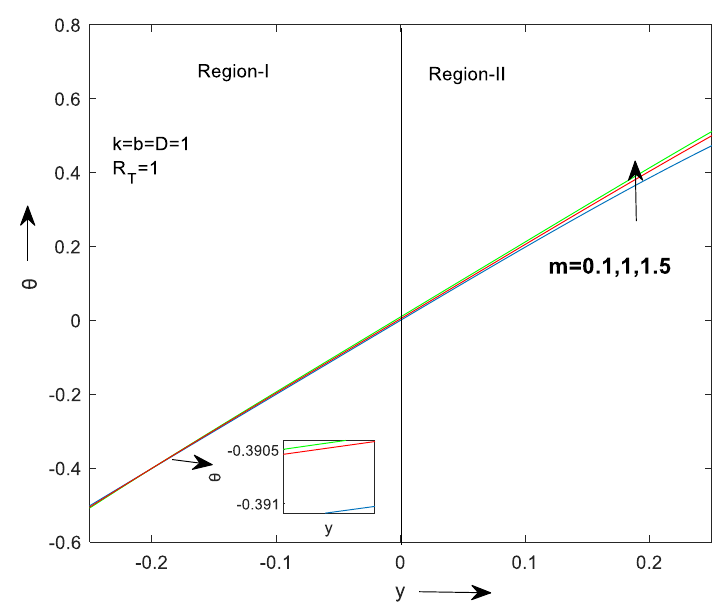
Fig. 5b. Temperature profile for different values of